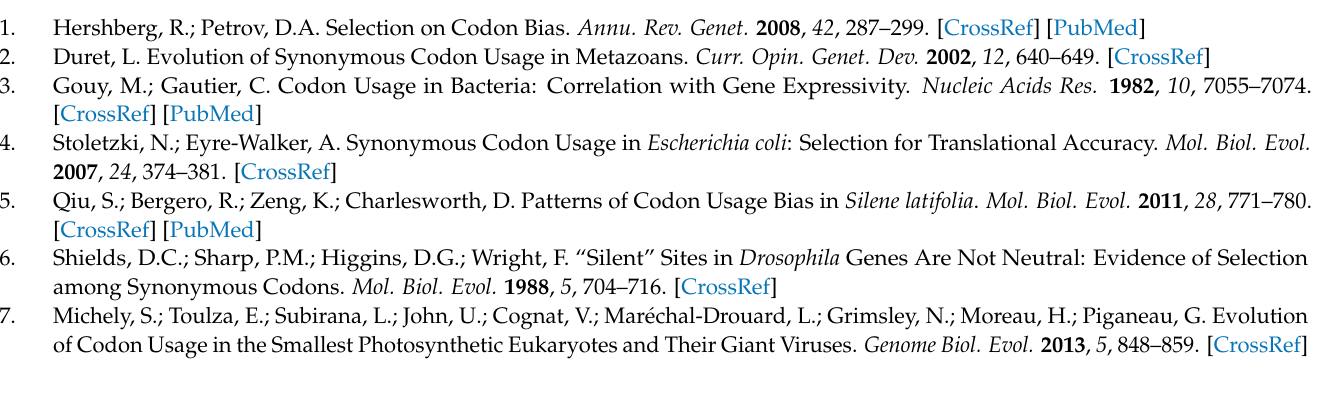
Table S2: Last nucleotide of preferred codons; Table S3: Silent divergence between the strains of the same speices. Archive.zip file includes files with preferred codons identified by